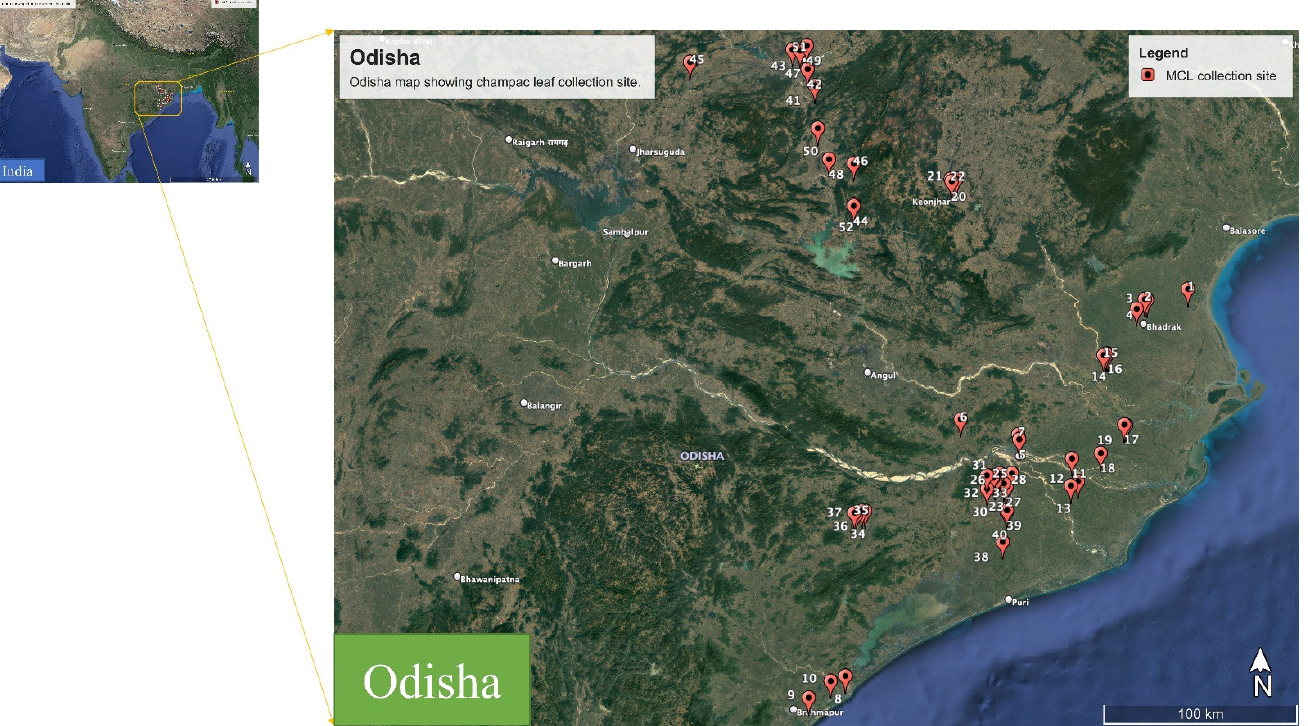
Figure 9. Map showing different regions of sample collection from Odisha, India.